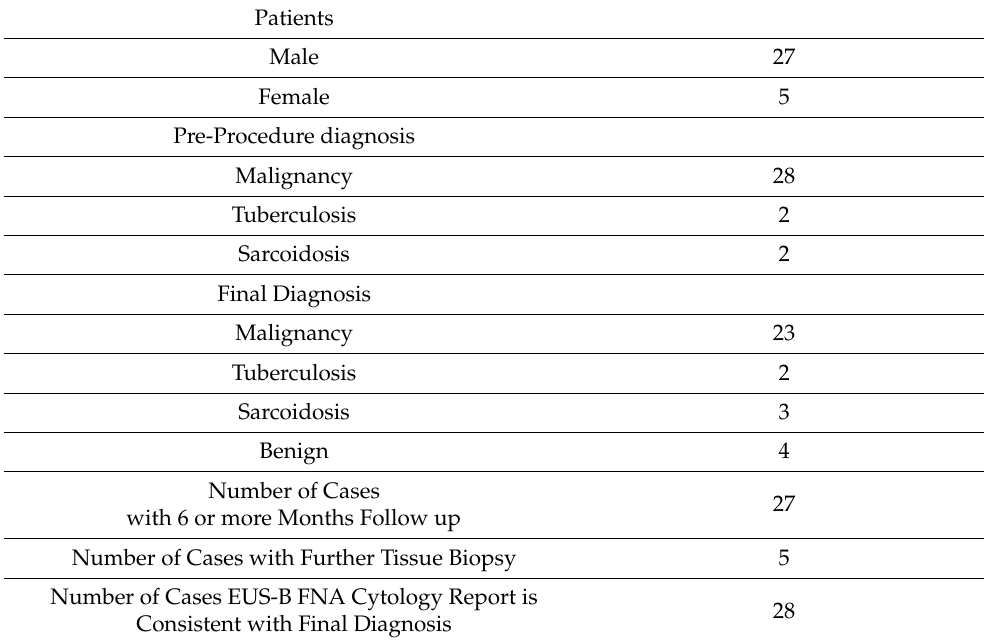
Table 1. Characteristics of 32 patients who underwent combined EBUS EUS-B.